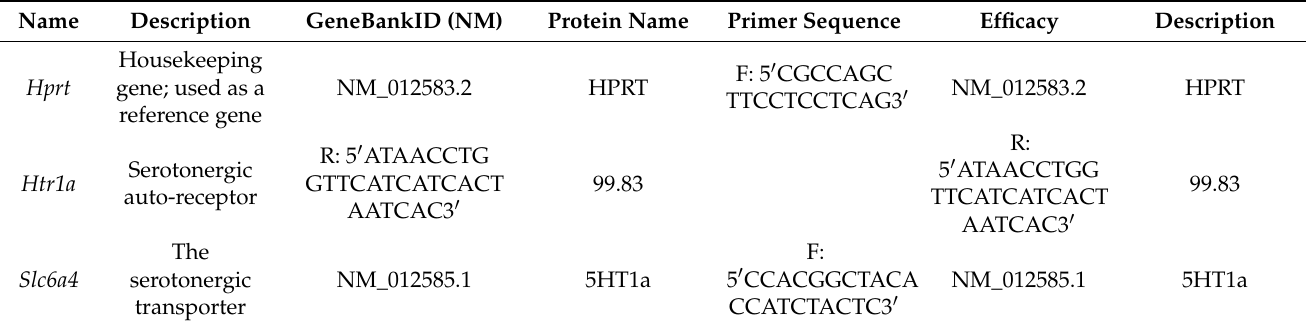
Table 5. Primers for mRNAs used for real-time